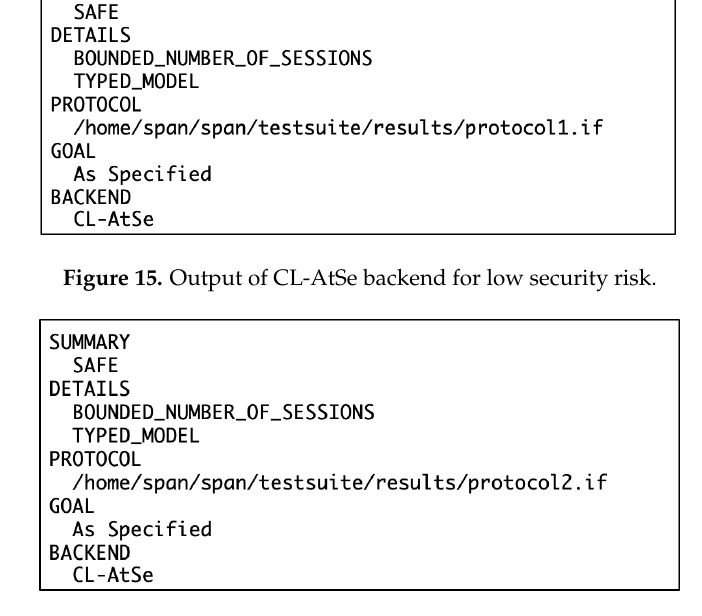
Figure 16. Output of CL-AtSe backend for high security